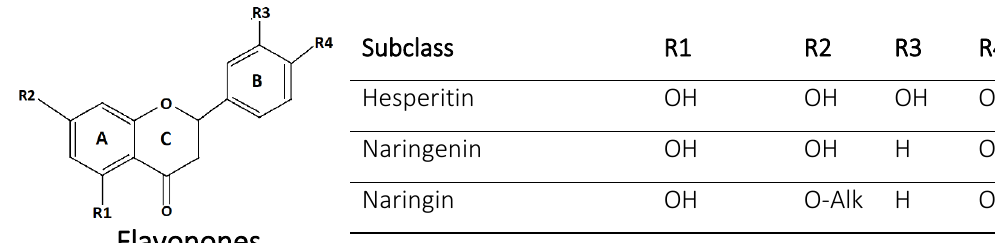
Figure 4. Flavonones: chemical structures, types and substitution positions in the basic skeleton.